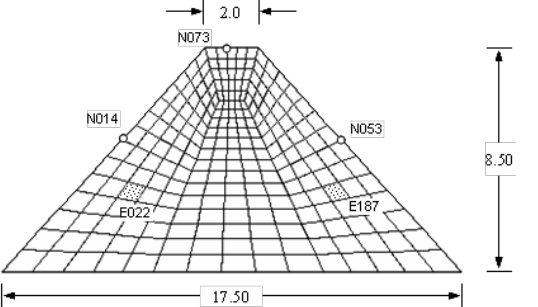
Figure 4. Finite element mesh and location of nodes and elements for records (all dimensions are in